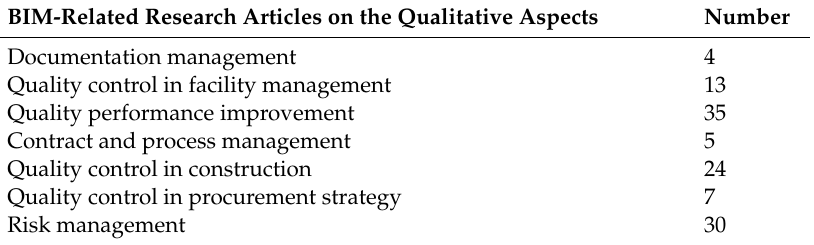
Table 6. The distribution of building information management (BIM) research articles on both the qualitative and quantitative